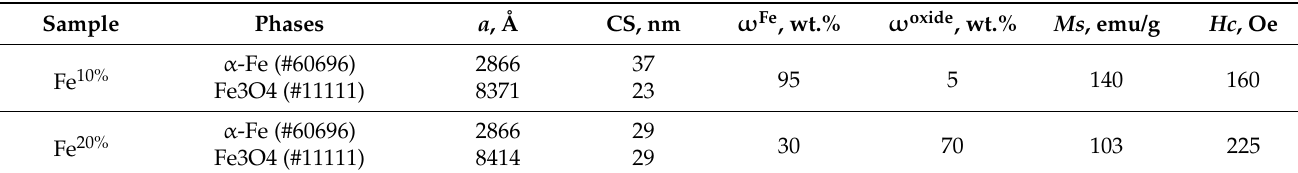
Table 1. XRD data, where a —lattice constant, CS—crystallite size, ω Fe and ω oxide —mass fraction of iron and Fe 3 O 4 oxide in each sample, calculated by means of the RIR method, Ms —saturation magnetization, Hc